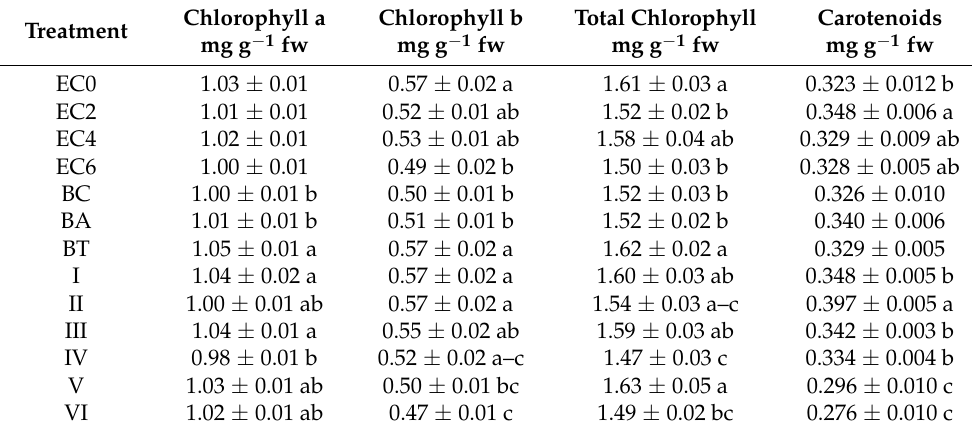
Table 4. Effect of salinity, biostimulant, and harvest on chlorophyll a, chlorophyll b, total chlorophylls, and carotenoid averages in Diplotaxis tenuifolia